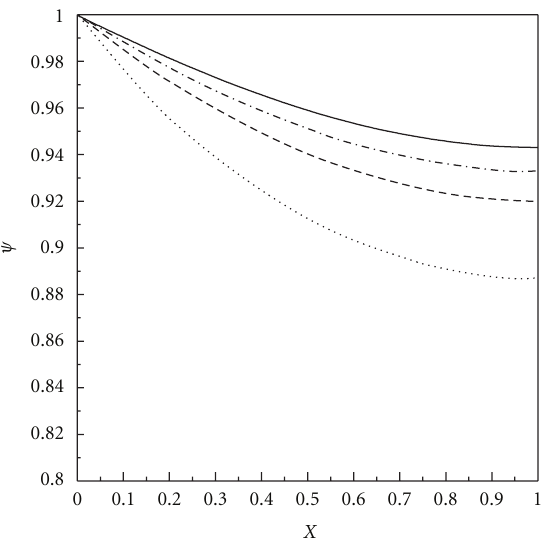
Figure 9: The distribution of dimensionless overpotential at A-A (cid:2) Figure 10: The distribution of dimensionless overpotential at A-A (cid:2) with di ff erent thickness and specific area of catalyst layer; T = with di ff erent operation temperature and methanol concentration; = 1 . 0 M, E 0 = 0 . 4 V, κ = 3 . 4 Ω − 1 m − 1 , D = 3 . 04 × 333K, c 0 l = 25 μ m, a = 1 . 0 × 10 5 m − 1 , E 0 = 0 . 5 V, κ e = 3 . 4 Ω − 1 m − 1 , D e = e e M = 1 . 0 M, dash line: 10 − 10 m 2 s − 1 , solid line: l = 10 μ m, a = 1 . 0 × 10 5 m − 1 , dash line: 3 . 04 × 10 − 10 m 2 s − 1 , solid line: T = 303K, c 0 M l = 25 μ m, a = 1 . 0 × 10 5 m − 1 , dot line: l = 50 μ m, a = 1 . 0 × 10 5 m − 1 , T = 333K, c 0 M = 1 . 0M, dot line: T = 363K, c 0 M = 1 . 0M, dash dot = 0 . 5 M. dash dot line: l = 10 μ m, a = 1 . 0 × 10 6 m − 1 . line: T = 333 K, c 0 M